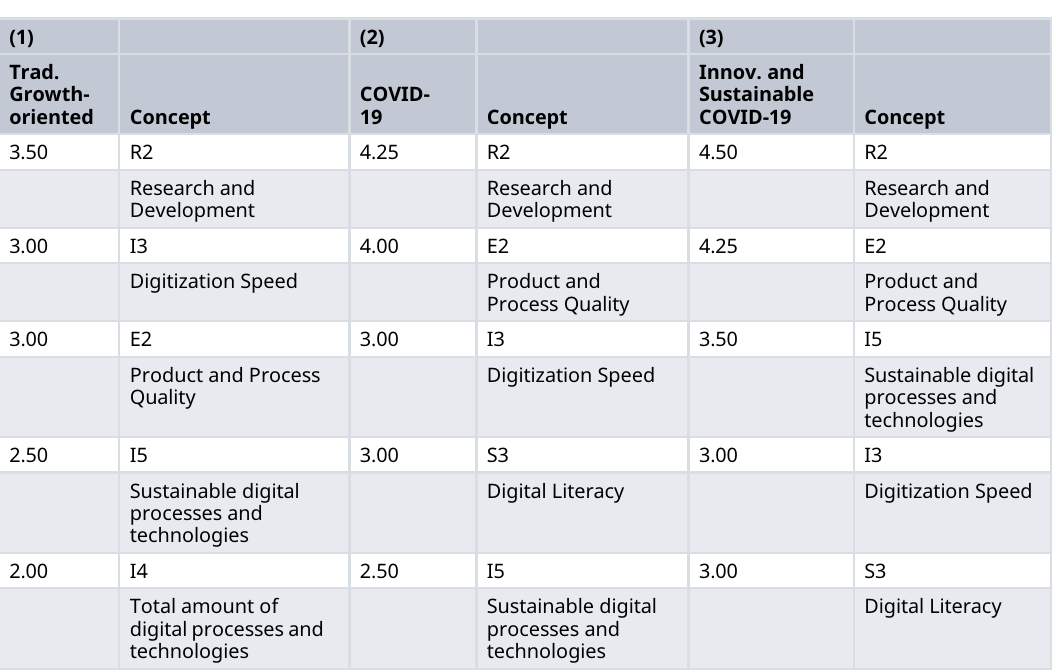
Table 14. Ranking of concepts due to network